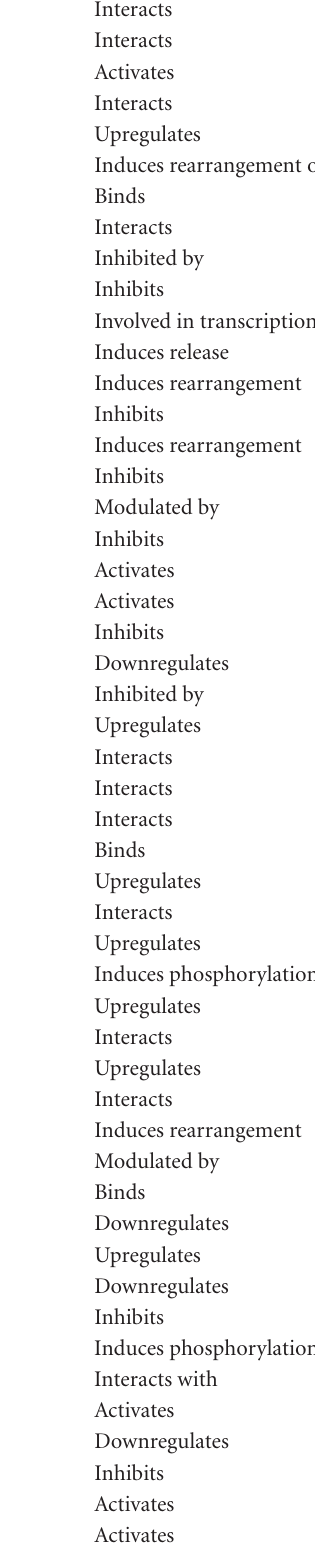
Table 1: List of all known Tat protein interactions and the nature of the functional activity compiled from PubMed (http://www.ncbi.nlm .nih.gov/pubmed/) and HIV-1, Human Protein Interaction Database (http://www.ncbi.nlm.nih.gov/RefSeq/HIVInteractions/). Human protein Type of activity with